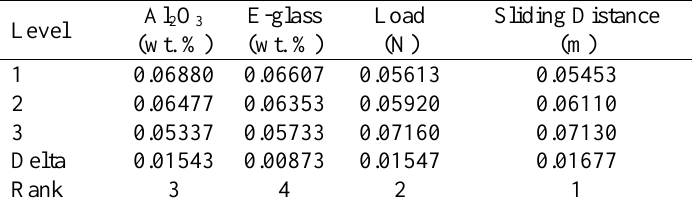
Table 3. Means wear rate of response